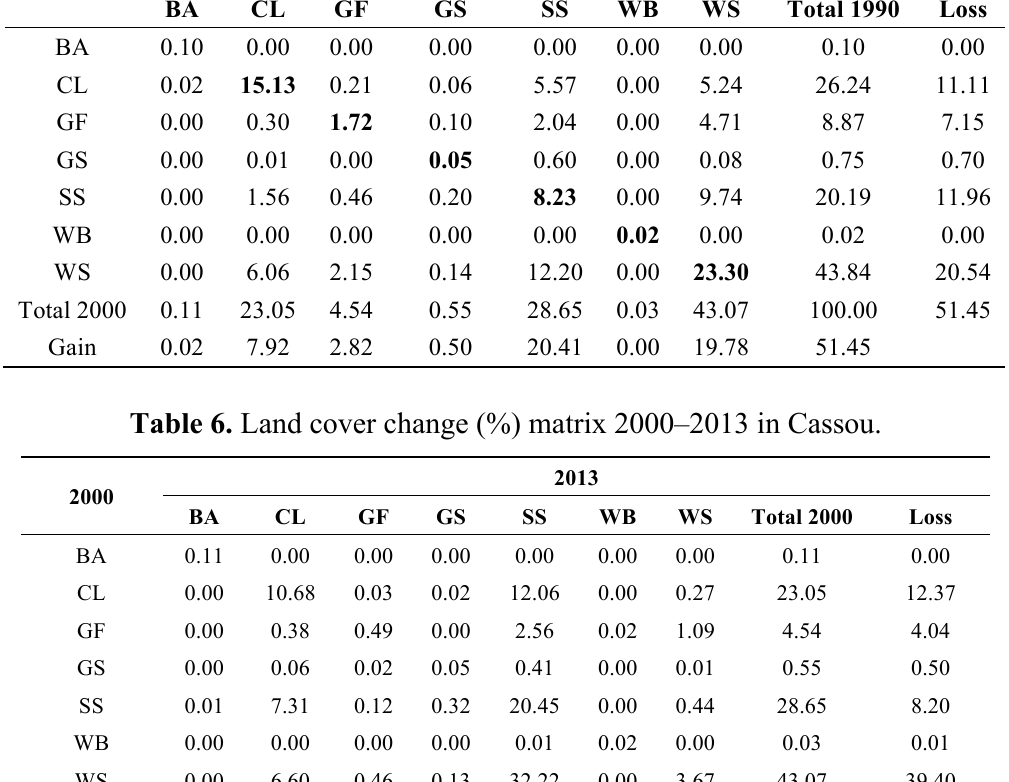
), and net change-to-persistence p